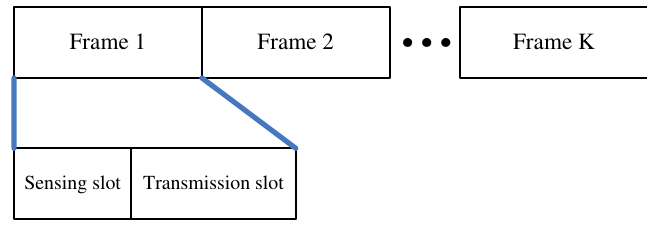
Figure 2. Traditional frame